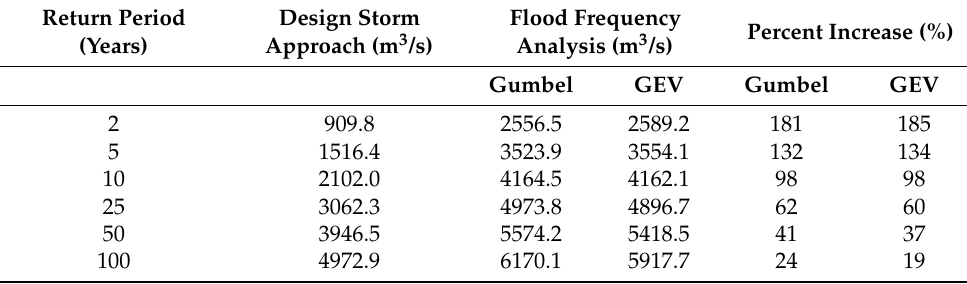
Table 6. Comparison of peak discharges estimated using the two